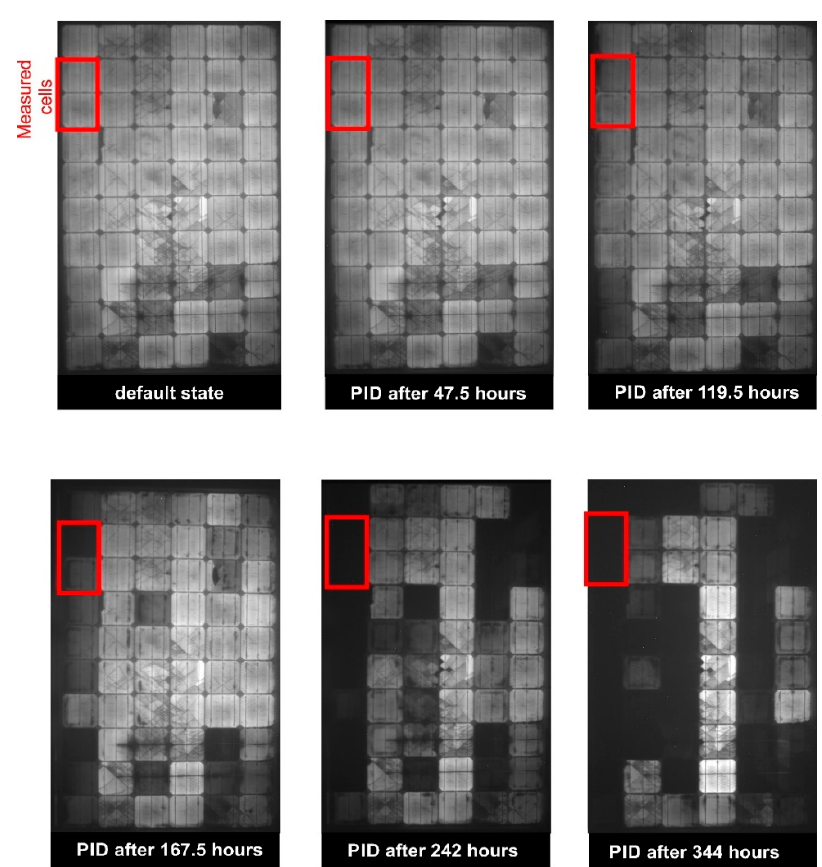
Figure 6. Electroluminescent images during degradation.